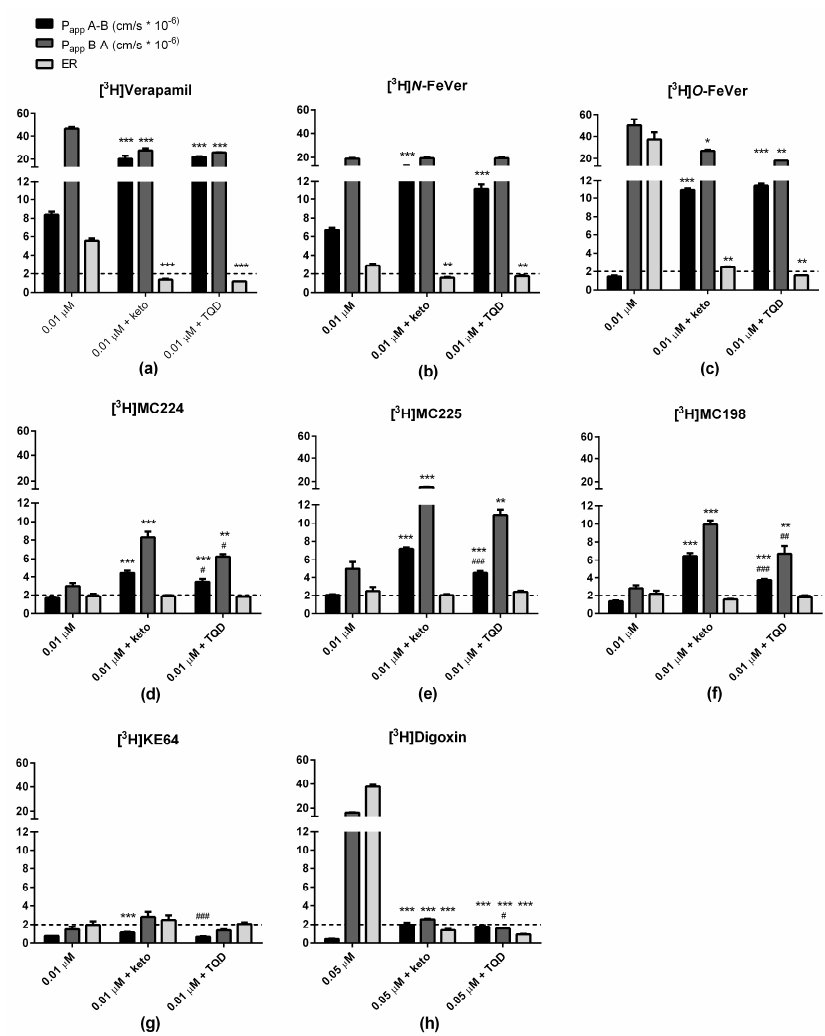
Figure 3. Bidirectional transport ( P app and ER) of ( a ) [ 3 H]verapamil, ( b ) [ 3 H] N -FeVer, ( c ) [ 3 H] O -FeVer, ( d ) [ 3 H]MC224, ( e ) [ 3 H]MC225, ( f ) [ 3 H]MC198, ( g ) [ 3 H]KE64 and ( h ) [ 3 H]digoxin in MDCKII-MDR1 cells (mean ± SEM) using baseline concentration of 0.01 µM ( n = 6) with co-incubation of the P-gp inhibitor ketoconazole at 25 µM (0.01 µM + keto, n = 3) and tariquidar at 10 µM (0.01 µM + TQD, n = 3). * Symbol represents a significant difference with 0.01 µM (* p < 0.05, ** p < 0.01, *** p < 0.001) and # symbol a significant difference with 0.01 µM + keto (# p < 0.05, ## p < 0.01, ### p < 0.001).